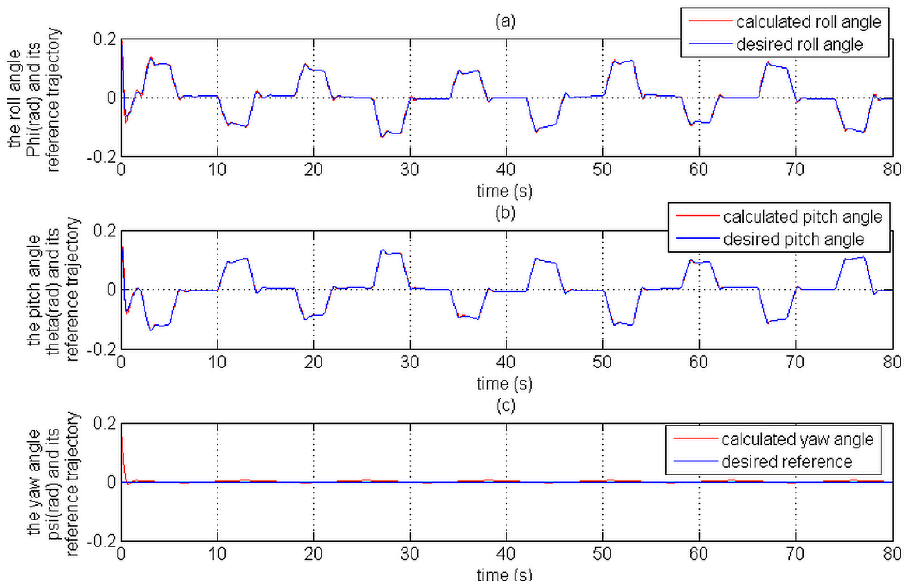
Figure 21. The attitude tracking evolution obtained by the PTCM: ( a ) roll angle evolution φ ( rad ) and its reference trajectory φ d ( rad ) ; ( b ) pitch angle evolution θ ( rad ) and its reference trajectory θ d ( rad ) ; ( c ) yaw angle evolution ψ ( rad ) and its reference trajectory ψ d ( rad ) .